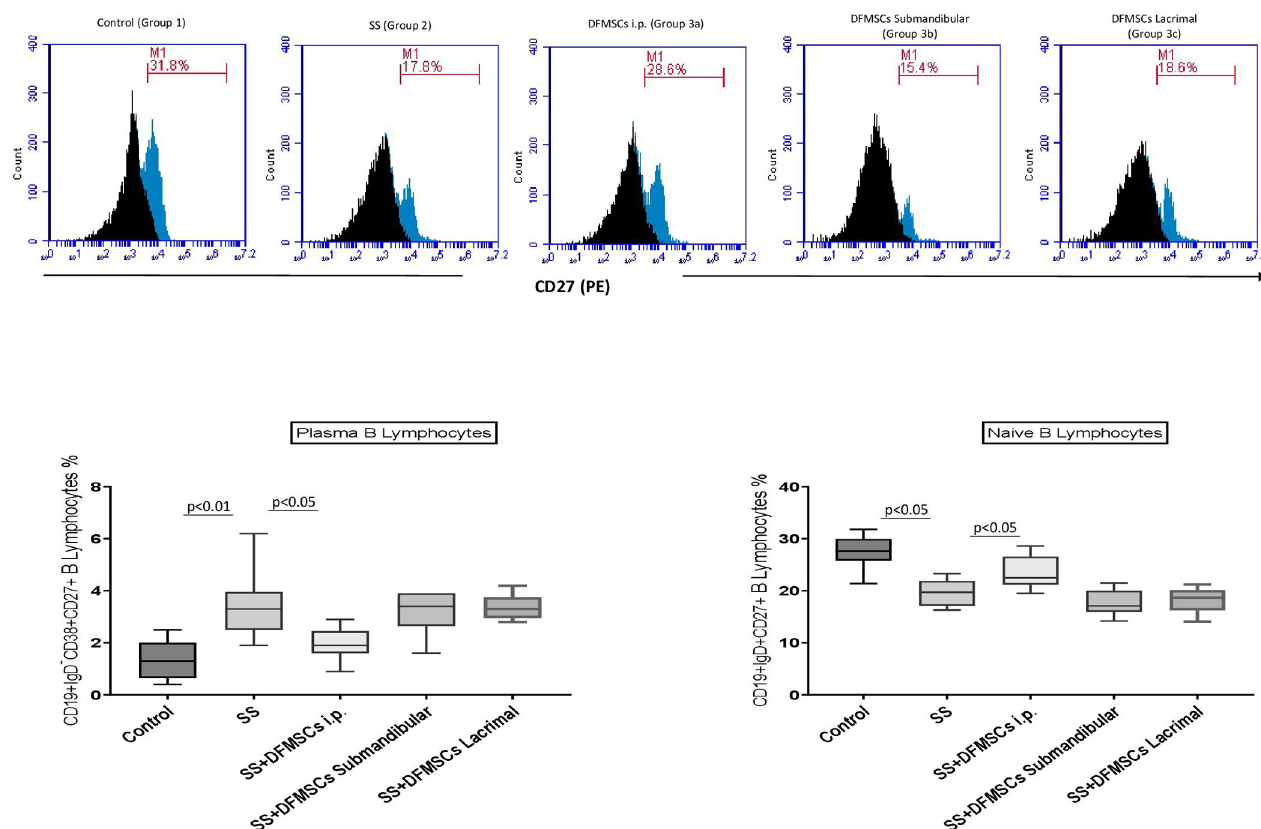
Fig 6. Flow cytometry analysis of plasma and na ï ve B cell subsets in the splenocytes. Intraperitoneal injection of DFMSCs significantly increased the ratio of CD19+IgD+CD27+ na ï ve B lymphocytes in Group 3a compared to Group 2 (p < 0.05). CD19+IgD-CD38+CD27+ plasma cell ratio was significantly high in Group 2 compared to Group 1 (p < 0.01). Intraperitoneal injection of DFMSCs significantly decreased the ratio of CD19+IgD-CD38+CD27+ plasma cells in Group 3a compared to Group 2 (p < 0.05). Submandibular and lacrimal injections of DFMSCs did not significantly change CD19+IgD+CD27+ and CD19 +IgD-CD38+CD27+ cell ratio in Group 3b and Group 3c when compared with Group 2 (p > 0.05).